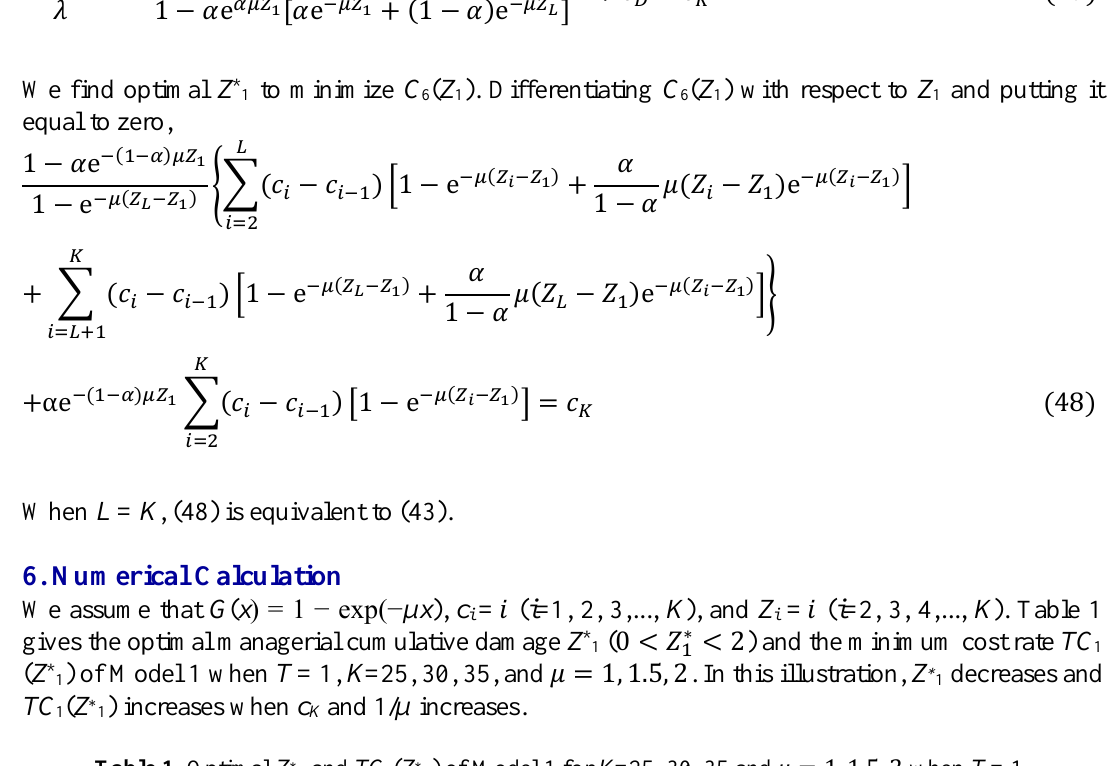
Table 1. Optimal Z ∗ 1 and TC 1 ( Z ∗ 1 ) of Model 1 for K =25, 30, 35 and 𝜇 = 1, 1.5, 2 when T =